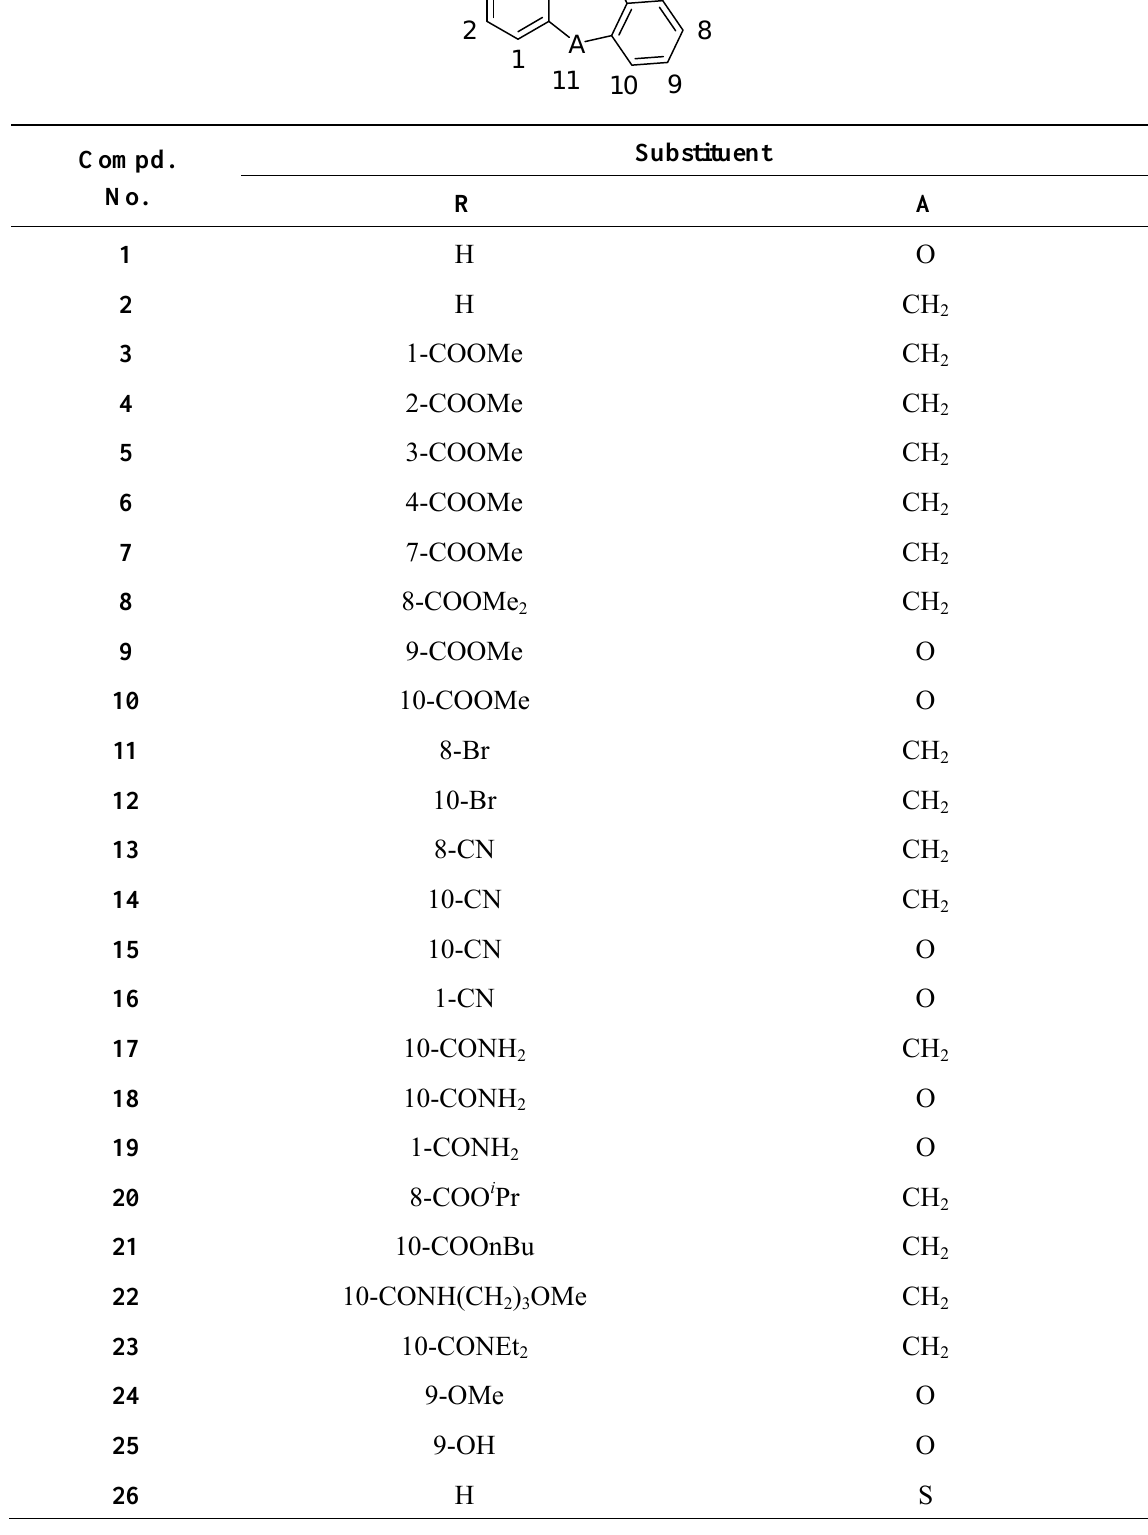
Table 1. The structures of the training and test set